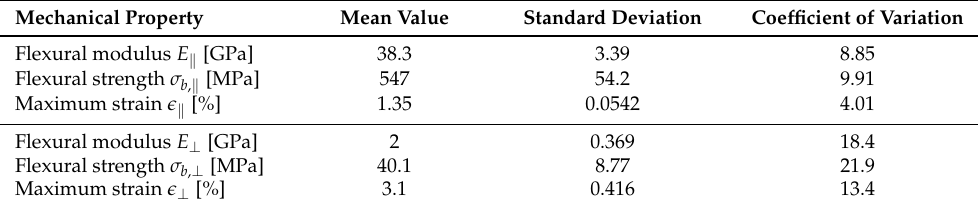
Table 3. Mechanical properties of 3D printed CF/PA6 from bending tests (statistical values). ( (cid:107) ) corresponds to the longitudinal direction (fiber direction is 0°). ( ⊥ ) corresponds to the transverse direction (fiber direction is